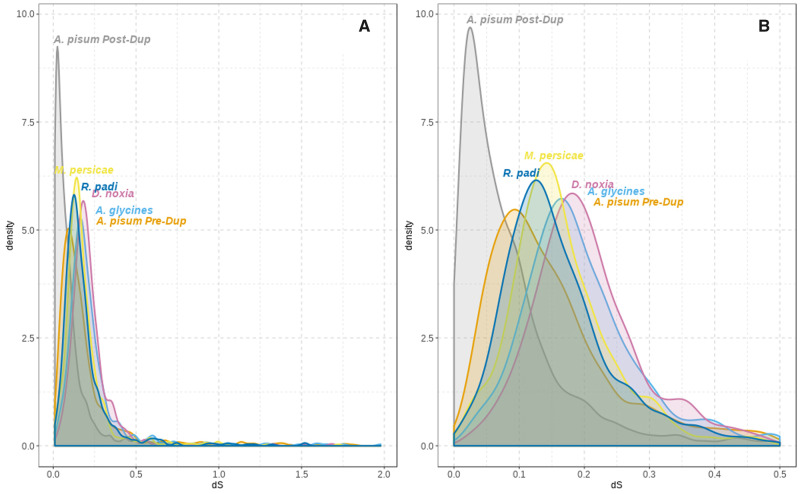
dS values for the selected duplications after filtering genes with dS > 2 and dS < 0.01 (A) and zoom by limiting x-axis to 0.5 (B). Cinara cedri was removed from this plot for visualization. dS for Acyrthosiphon pisum was calculated before (A. pisum Pre-Dup) and after (A. pisum Post-Dup) the duplication took place. See figure 1B for “Pre-Dup” and “Post-Dup” explanation.